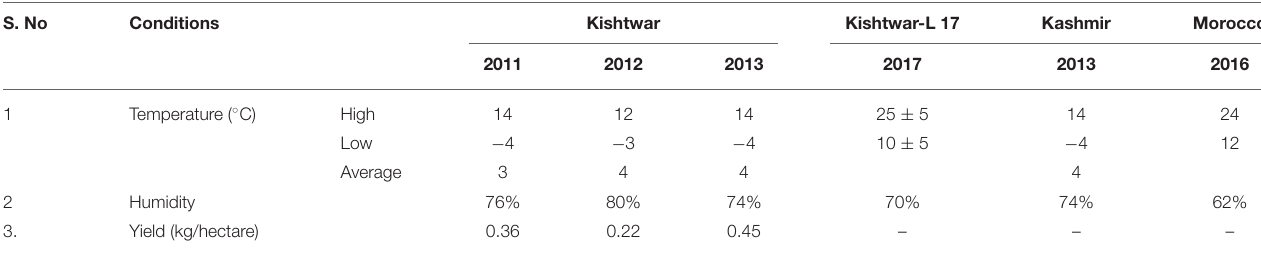
TABLE 2 | Mapping percentage of reads to different domains in all six samples [Kishtwar 2011 (C11), Kishtwar 2012 (C12), Kishtwar 2013 (C13), Kishtwar-L 17, Kashmir (2013), and Morocco (2016)]. Domain C11 (%) C12 (%) C13 (%) Kishtwar-L 17 (%) Kashmir (%) Morocco (%) Bacteria 96.3 Eukaryota Archaea